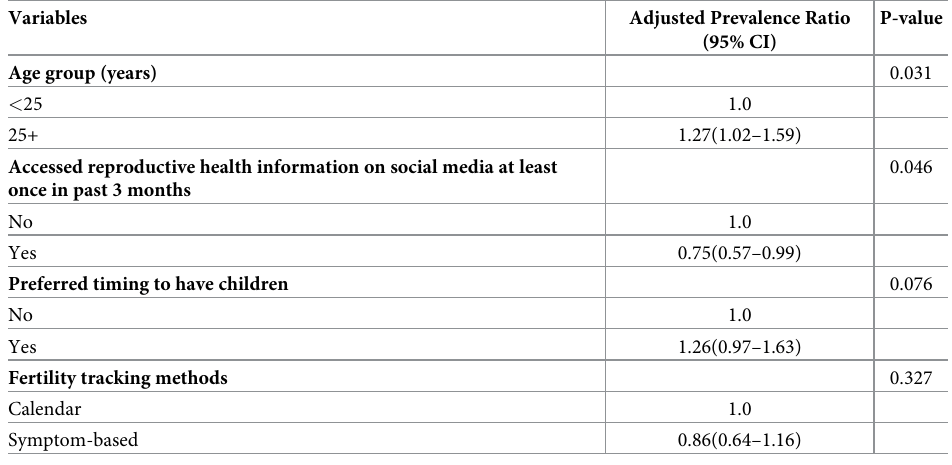
Table 2. Multivariable Poisson regression model assessing predictors of fertility awareness knowledge.